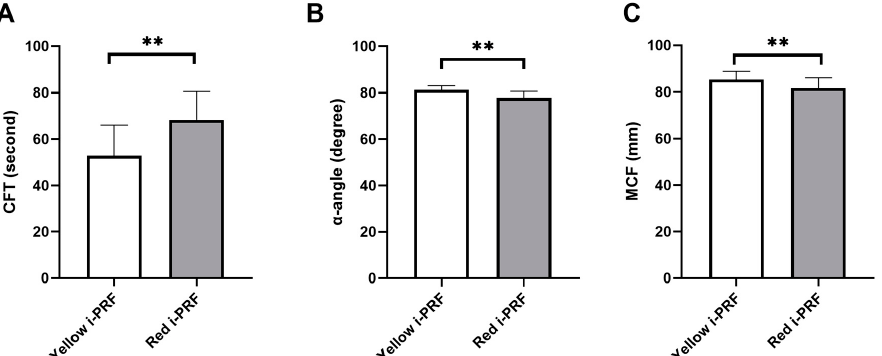
Figure 1. Rotational thromboelastometry (ROTEM ® ) analysis demonstrating ( A ) clot formation time (CFT), ( B ) α -angle, and ( C ) maximum clot firmness (MCF) of the yellow injectable platelet-rich fibrin (i-PRF) and the red i-PRF. ** p < 0.01.